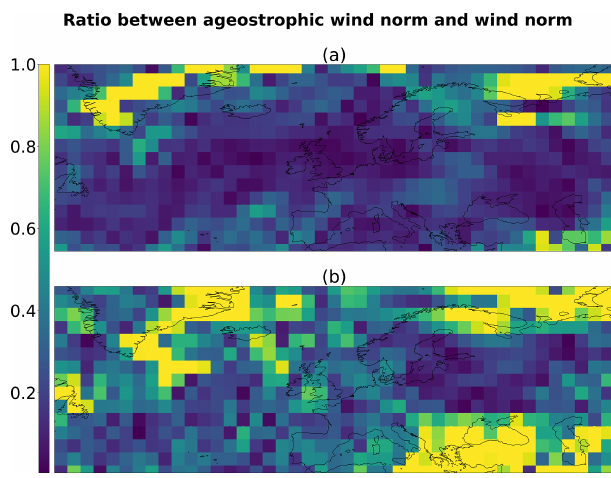
Figure 20. Relative error in the norm between geostrophic wind and normal wind shown in Fig. 19 for the situation taken from dataset (a) and generated (b)